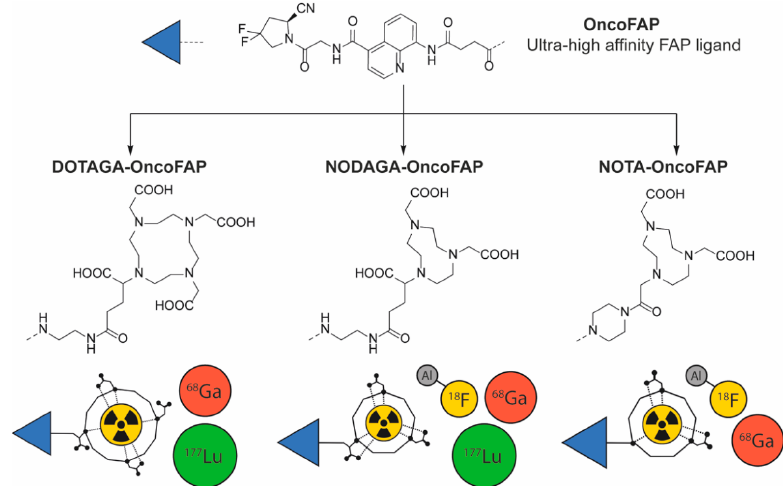
Figure 1. Chemical structures of OncoFAP and its conjugates with radiometal chelators. OncoFAP is a portable small organic ligand that targets Fibroblast Activation Protein in solid tumors with ultra-high affinity. Structures of OncoFAP and its DOTAGA, NODAGA and NOTA conjugates are presented. DOTAGA-OncoFAP conjugate was radiolabeled with gallium-68 and lutetium-177. NODAGA-OncoFAP conjugate was radiolabeled with gallium-68, lutetium-177 and fluorine-18. NOTA-OncoFAP- derivative was radiolabeled with gallium-68 and fluorine-18.